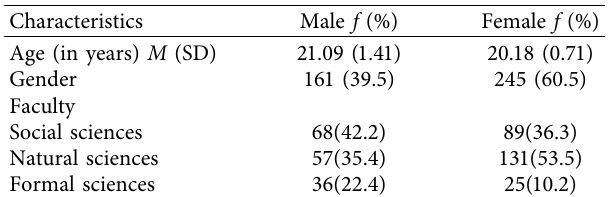
Table 1: Descriptive statistics of demographic characteristics ( N �